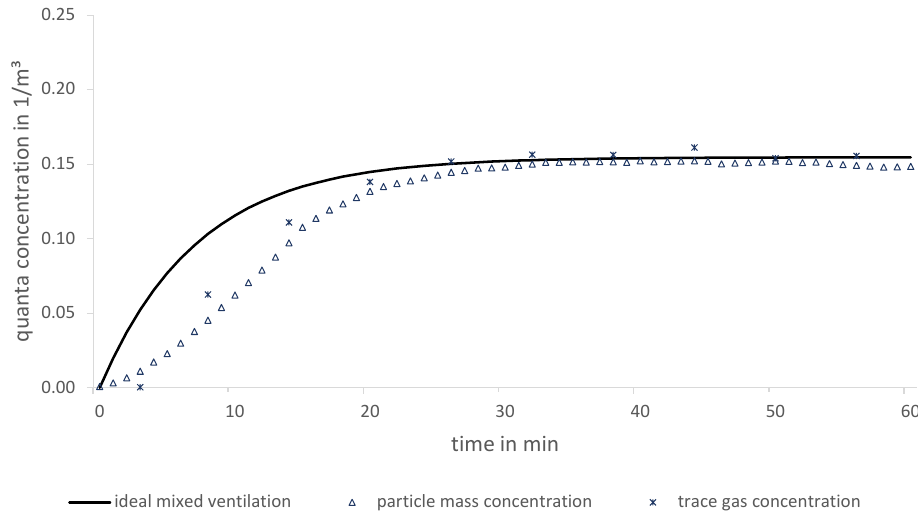
Figure 2. Comparison between particle and trace gas measurement as a function of quanta concentra- tion over time exemplified in a conference room (position